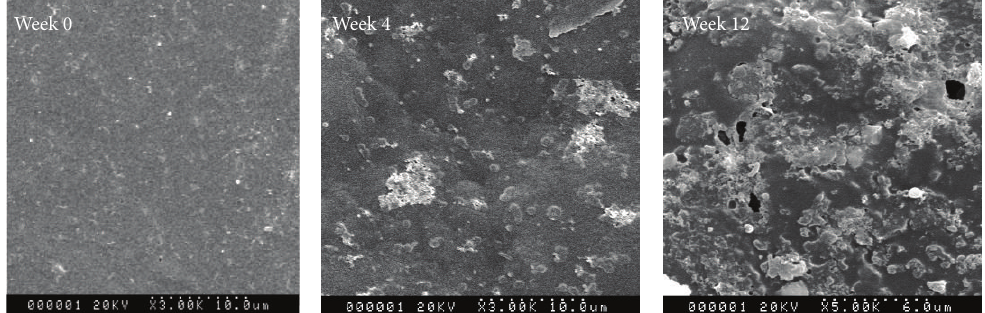
Figure 9: SEM micrographs of PUHE-50 film at various stages of degradation at pH